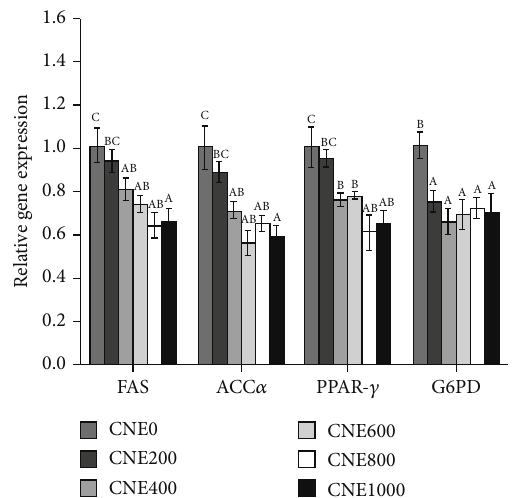
Figure 3: Relative gene expression of FAS , ACC α , PPAR- γ , and G6PD in juvenile H . otakii -fed diets supplemented with CNE levels. Mean values for the same gene with di ff erent letters were signi fi cantly di ff erent ( P < 0 : 05